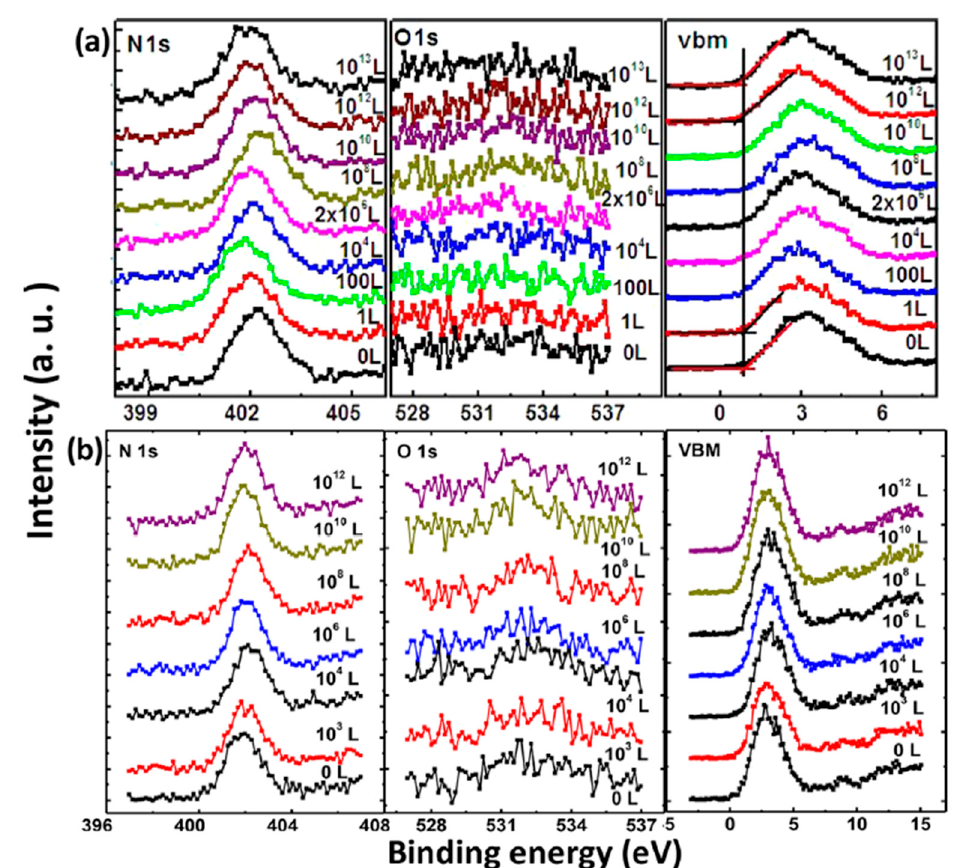
Figure 3. XPS spectra of N 1s, O 1s, and the VBM region of co-evaporated MAPbI 3 thin film during ( a ) oxygen exposure and ( b ) dry air exposure From Ref. [37] with permission.